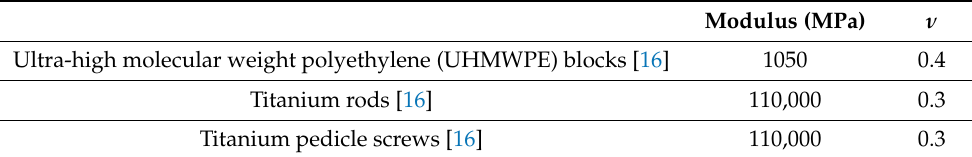
Table 1. Material properties of finite element